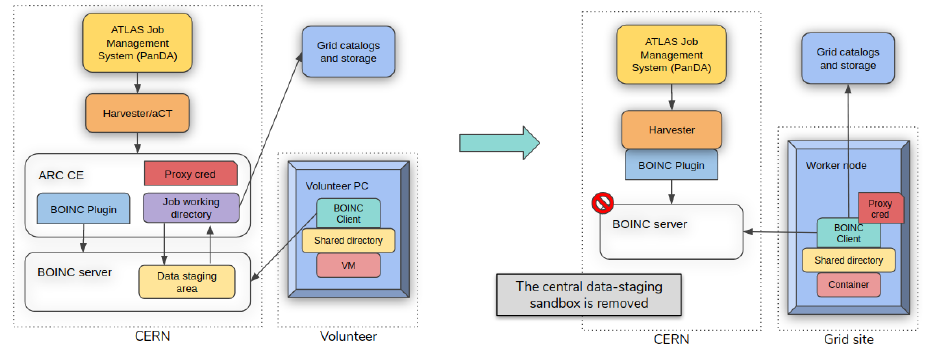
Figure 2. Evolution of the architecture of ATLAS@Home to support trusted